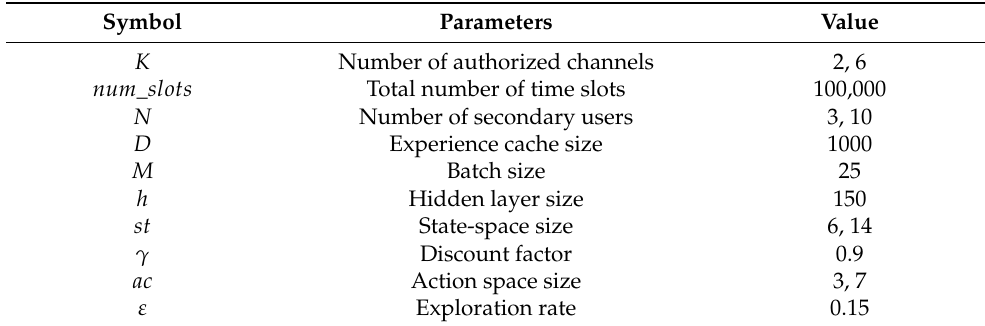
Table 1. Dueling deep Q network (DDQN) parameters.